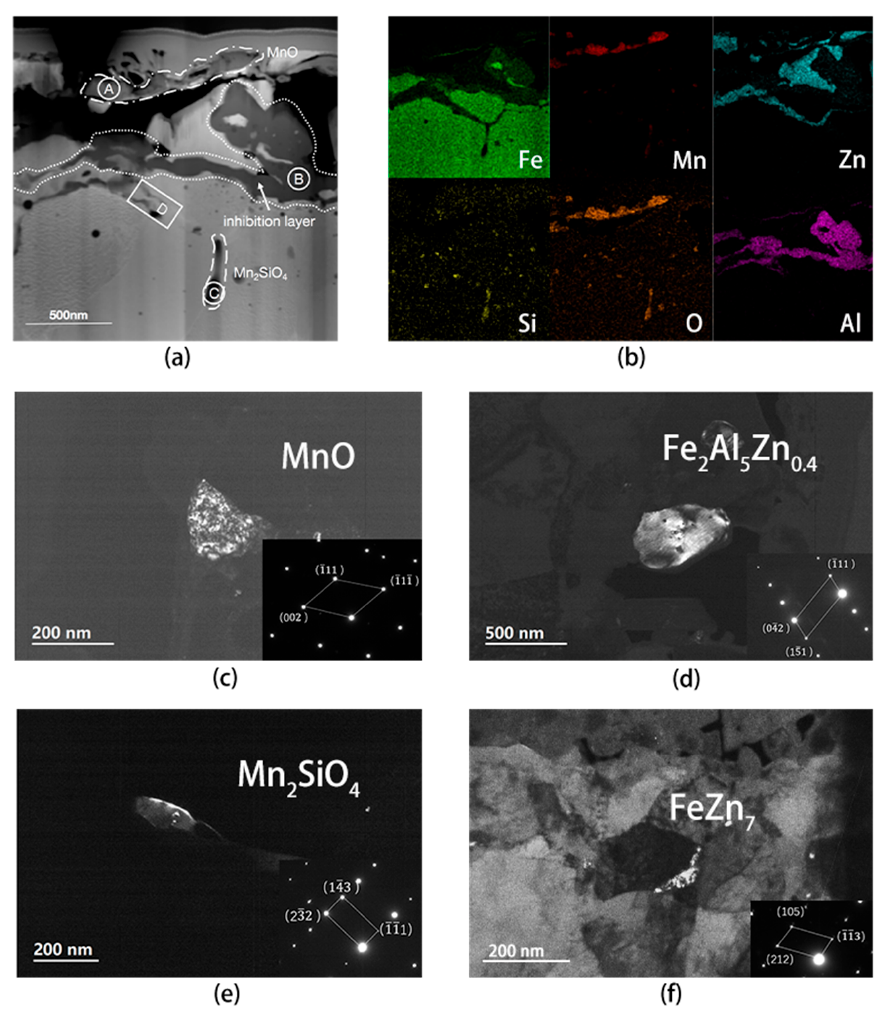
Figure 13. ( a ) TEM analysis of the Zn coating / Fe substrate interface of the galvanized sample 5#. ( b ) cross-sectional elemental maps of the area shown in ( a ). ( c ) Dark filed image and di ff raction pattern of the oxide particle corresponding to zone A in ( a ). ( d ) Dark filed image and di ff raction pattern of the inhibition layer corresponding to zone B in ( a ). ( e ) Dark filed image and di ff raction pattern of the oxide particle corresponding to zone C in ( a ). ( f ) Dark filed image and di ff raction pattern of the Fe-Zn intermetallic corresponding to zone D in ( a